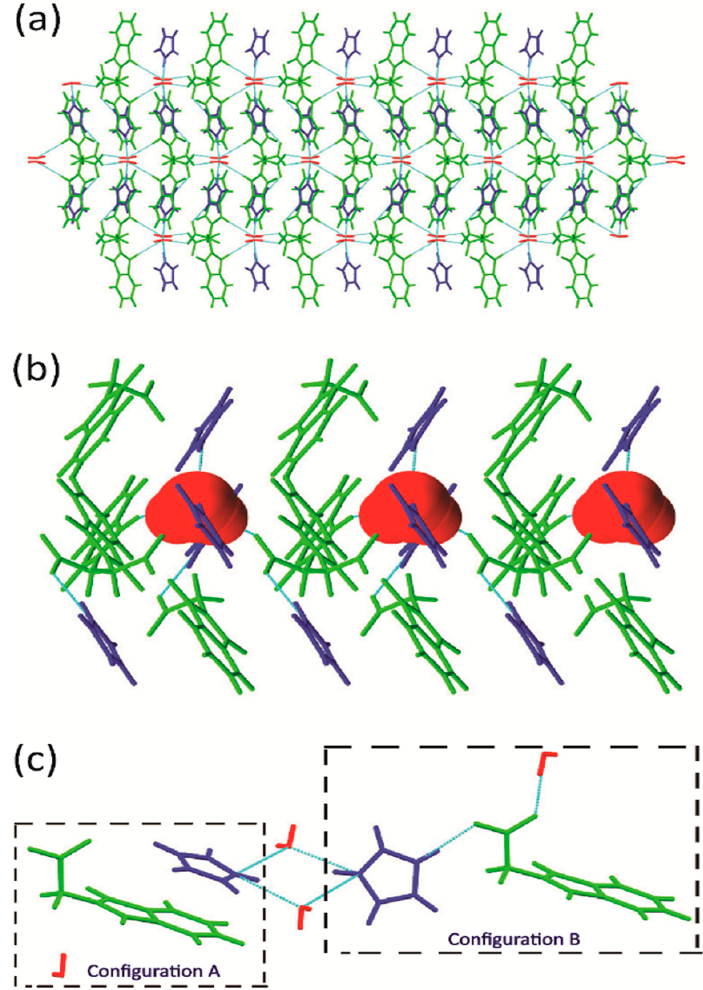
Figure 5. Supramolecular assembly of IM + –NPG − –HYD along different crystallographic axes ( a ) a-axis, ( b ) mixed stacking donor-acceptor columns connected to water through hydrogen bonds, and ( c ) configurations A and B crystallized within the framework of supramolecular assembly. Table 3. Hydrogen bonds in IM + –NPG − –HYD.